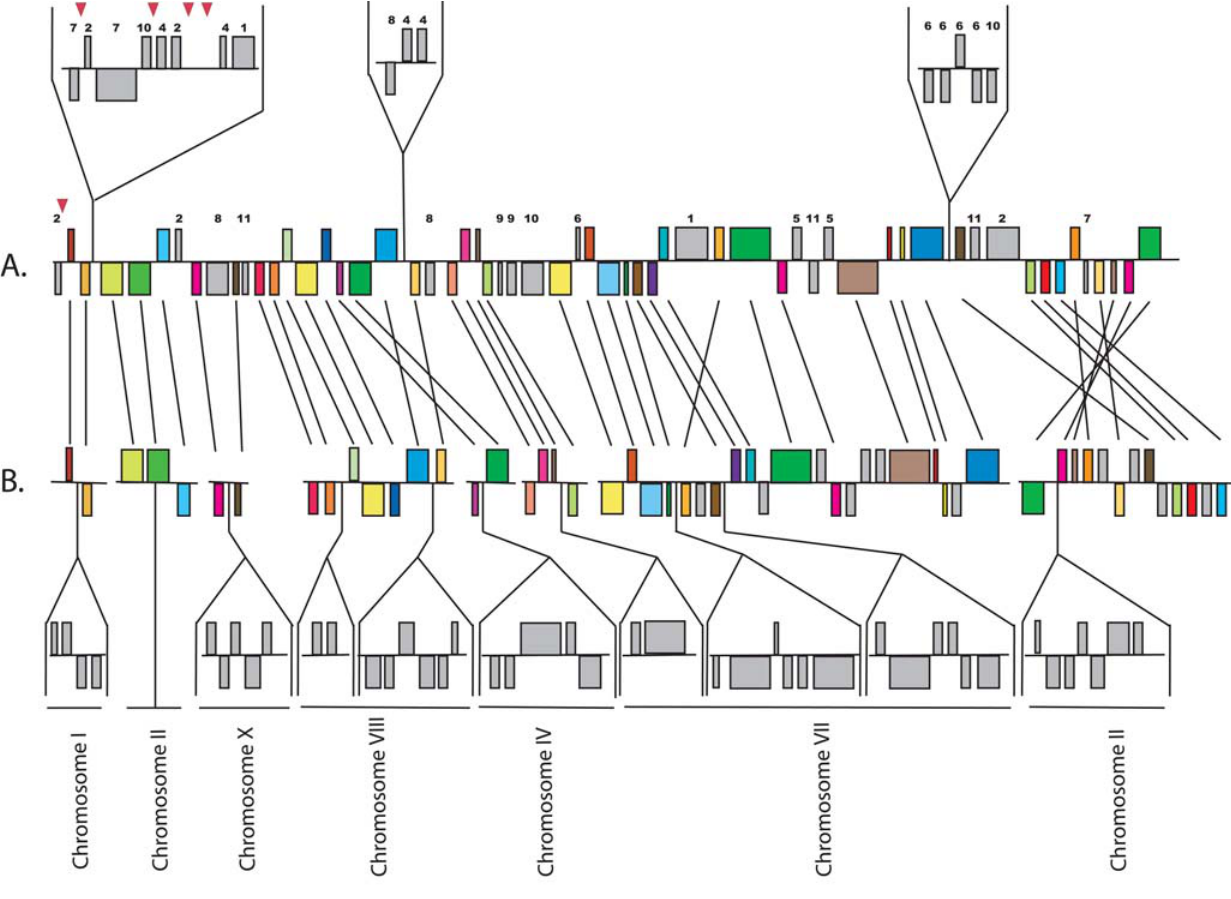
Figure 4. Analysis of contigs included in the scaffold SC_1888 and gene order comparisons between the E.bieneusi(A) and E.cuniculi(B) orthologues.